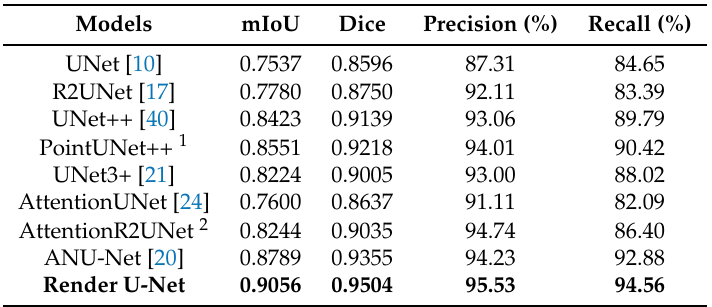
Table 4. Performance of liver segmentation for MRI